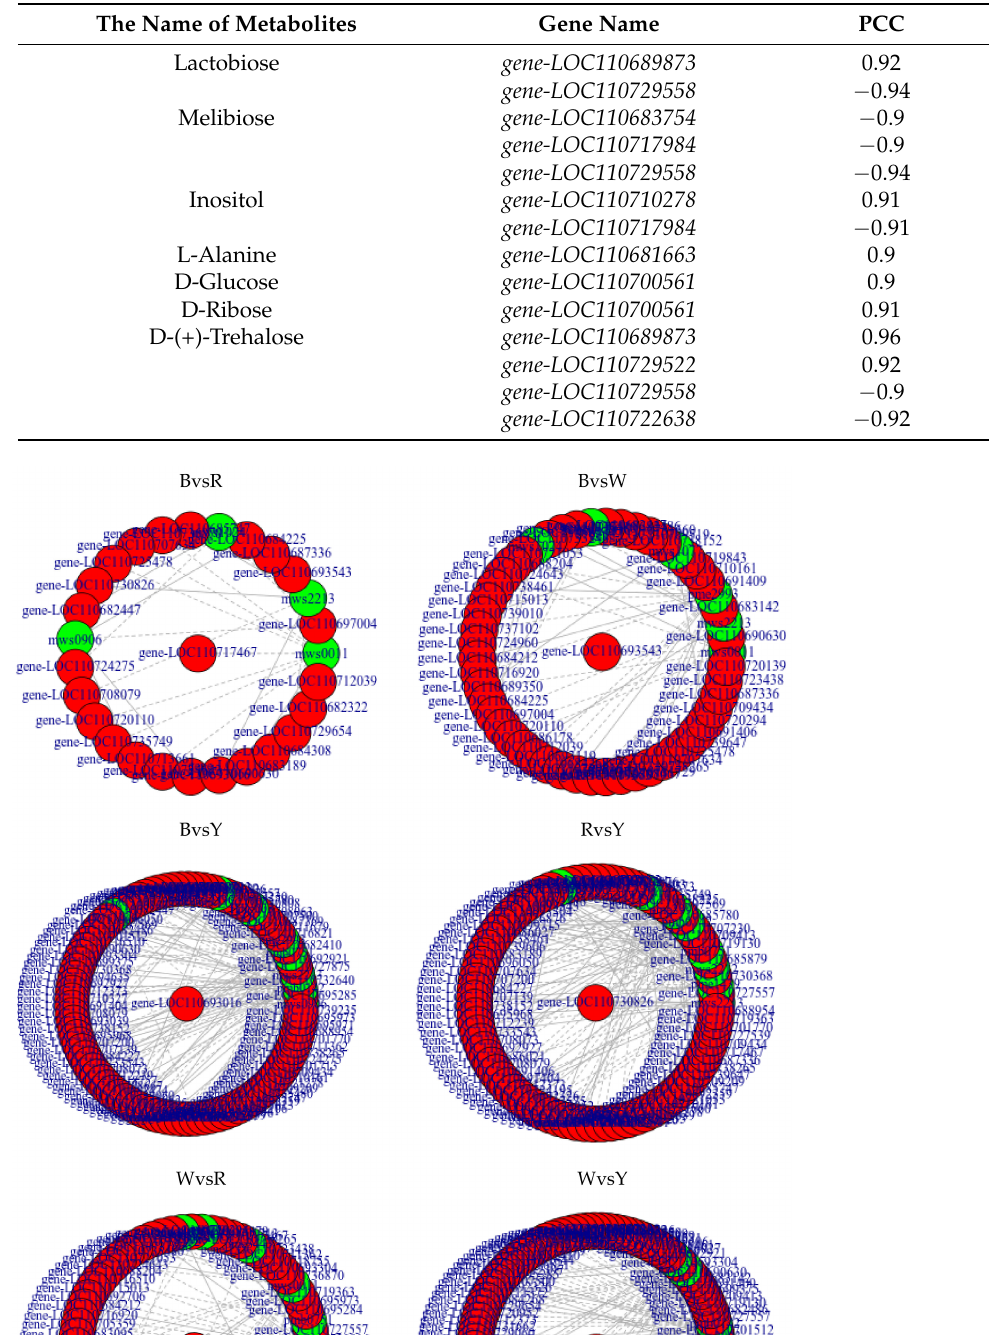
Table 6. Correlation between differential genes and differential metabolites in the ABC transporter pathway.